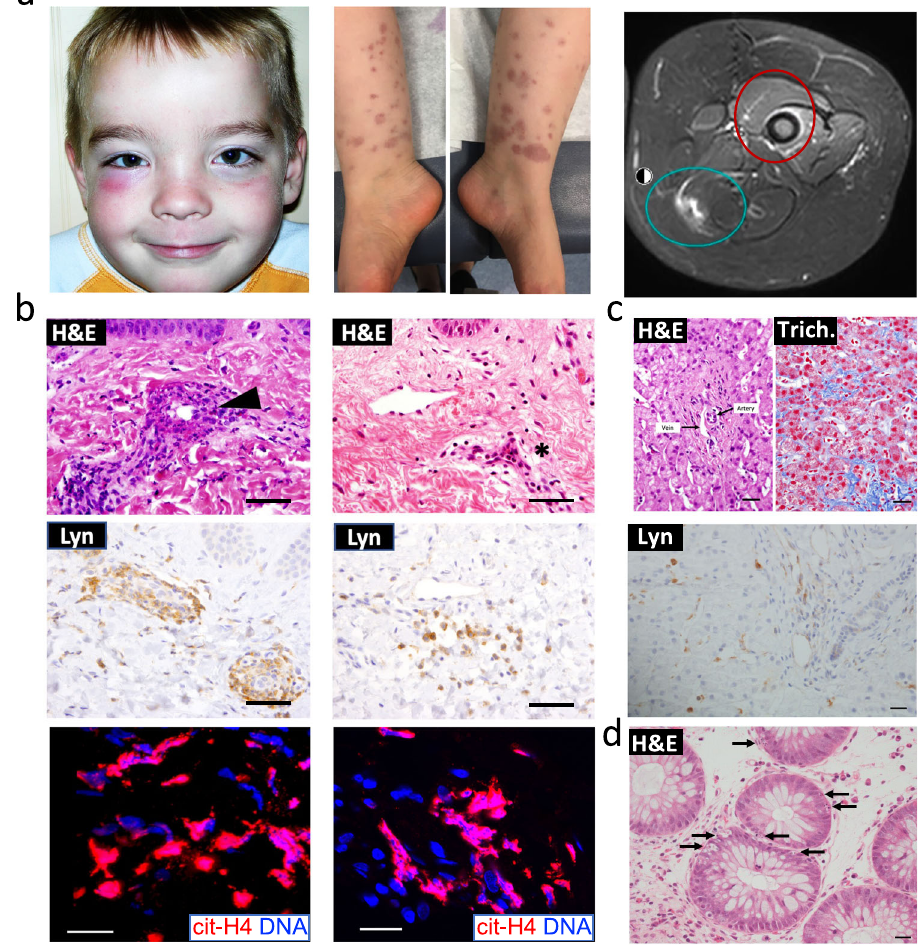
Fig. 2 | Clinical and histopathologic features of patients with LYN gain-of- function mutations. a Periorbital edema and erythema in Pt.2 (left panel), non- blanching vascular rashes in Pt.1 ’ s lower extremities (center panel), and left thigh MRI from Pt.1 (right panel) depicting fasciitis (green circle) and periostitis (red circle)areshown. b Hematoxylin&eosin(H&E)stainingfromlesionalskinbiopsies ofPt.1( fi rstcolumnimages)andPt.2(secondcolumnimages)showdestructionofa small vessel with surrounding in fl ammatory cells in Pt.1 (black arrow) and a peri- vascular in fi ltrate in Pt.2 (asterisk) (upper panels, scale bars, 100 μ m). The endo- thelial cells and surrounding neutrophils are Lyn kinase (Lyn) positive in both patients (middle panels, scale bars, 100 μ m). The lower panels show the localized